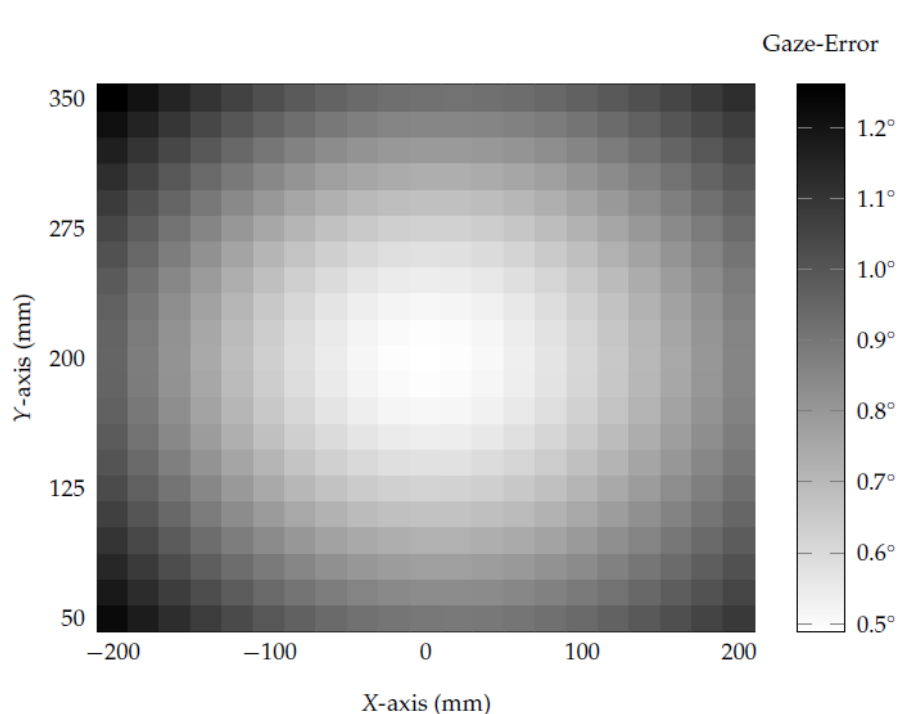
Figure 9. This heatmap illustrates the eye-camera location’s influence on the traditional homography- based gaze estimation method’s accuracy. The eye-camera has moved in a grid of 21 × 21 × 21 positions (i.e., 9.261 settings). Each element in this heatmap represents the gaze error average of 21 camera displacements along the z -axis. When the optical axis, screen axis, and camera axis are aligned ( X = 0 mm and Y = 200 mm), the gaze error is 0.49 ◦